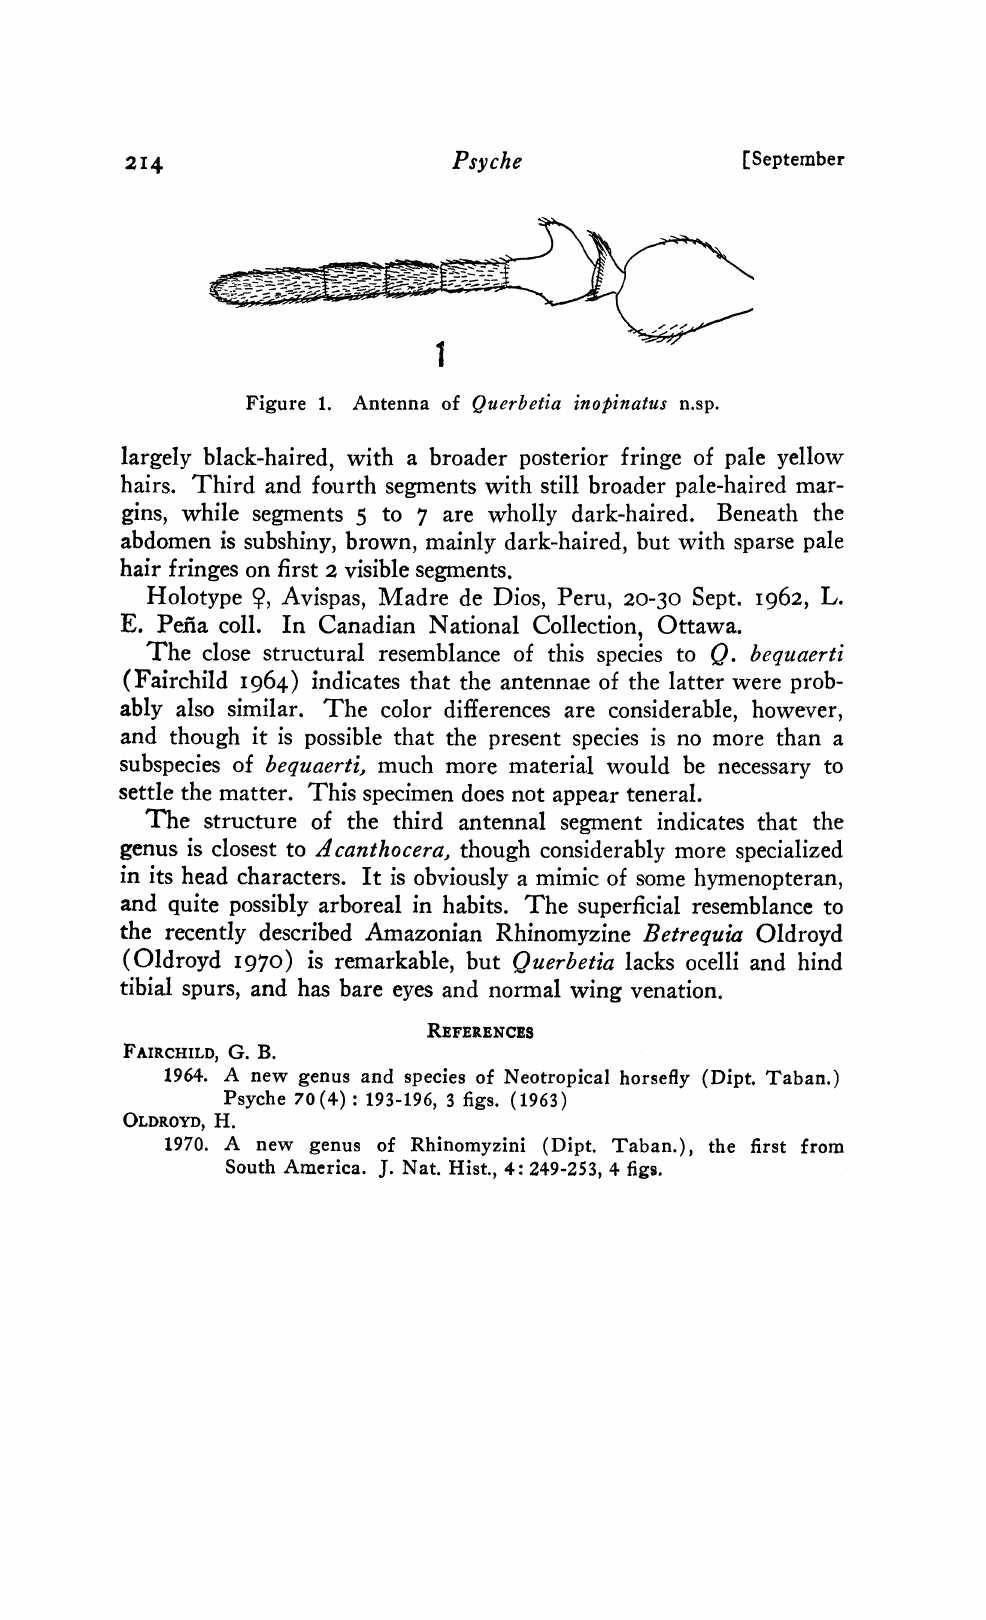
FAIRCHILD, G. B. OLDROYD